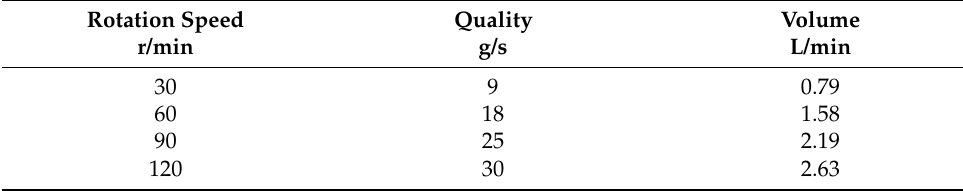
Table 2. Relationship between the pump speed and flow.